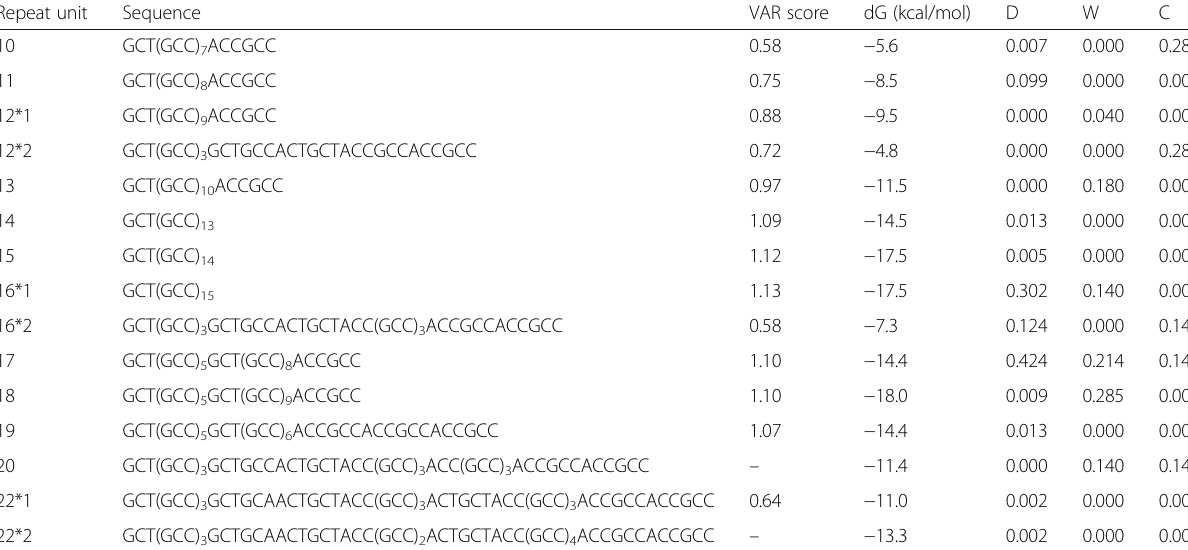
Table 2 5 ′ UTR microsatellite repeat length diversity, sequence and occurrence observed in dog (D), wolf (W), and coyote (C) Repeat